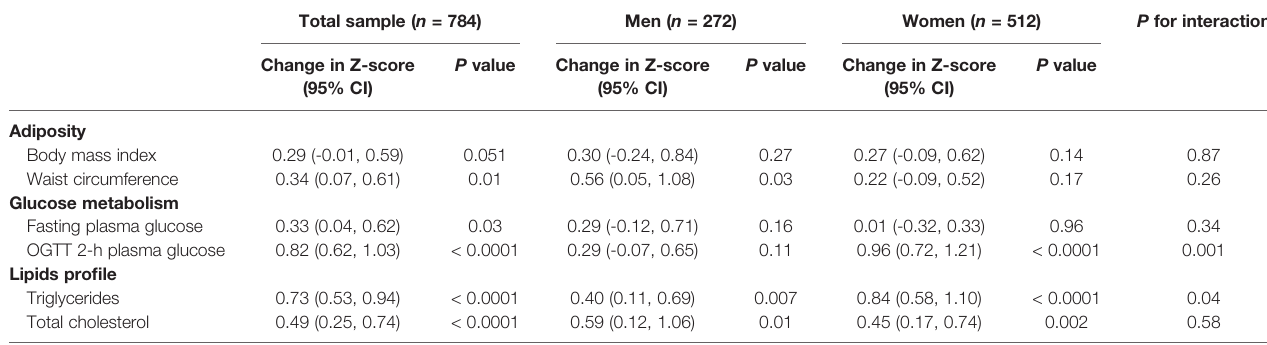
TABLE 4 | Adjusted changes (95% CI) in Z-score of metabolic traits per 1-unit increase in log10-RBP4 by using the GEE